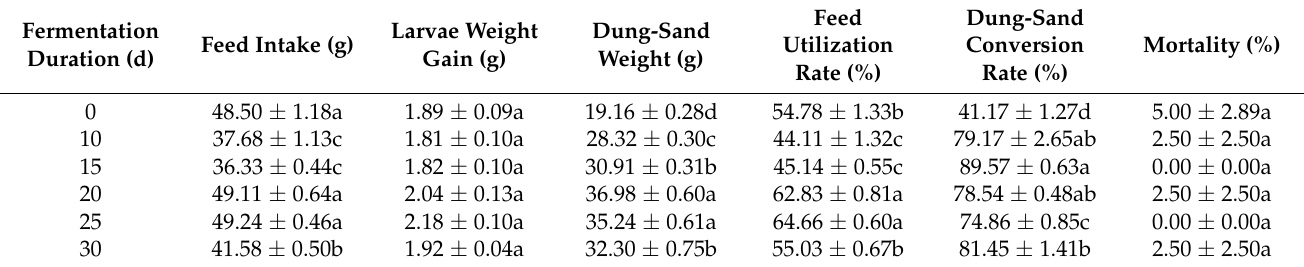
Table 3. Transformation capability of the 3rd instar larvae of P. brevitarsis on CS under different fermentation